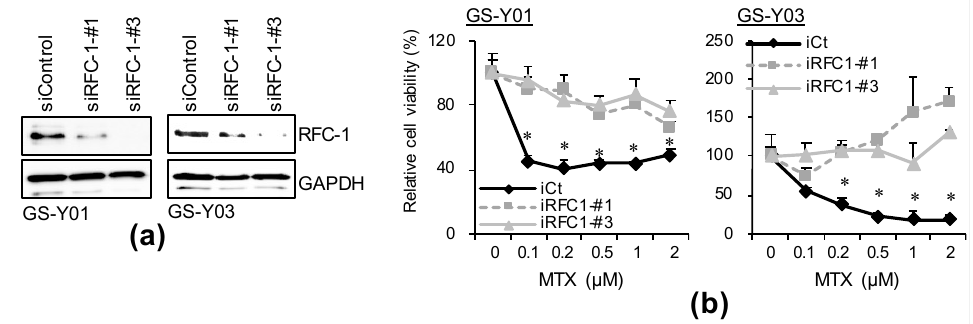
Figure 5. Selective toxicity of MTX to GSCs is dependent on RFC-1 expression. ( a ) GS-Y01 and GS-Y03 cells (2–5 × 10 5 ) were transiently transfected with an siRNA against RFC-1 (siRFC-1) or with control siRNA (siControl) and cultured for 4 days. The cells were subjected to immunoblotting analysis for RFC-1 and GAPDH. ( b ) The siRNA-transfected cells were treated with MTX at the indicated concentrations for 3 days and then subjected to WST-8 analysis. * p < 0.05 vs. siControl-transfected cells treated with each concentration of MTX by Dunnett’s test.